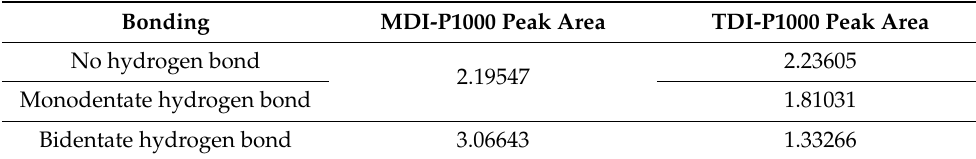
Table 3. Peak area for respective bonds in